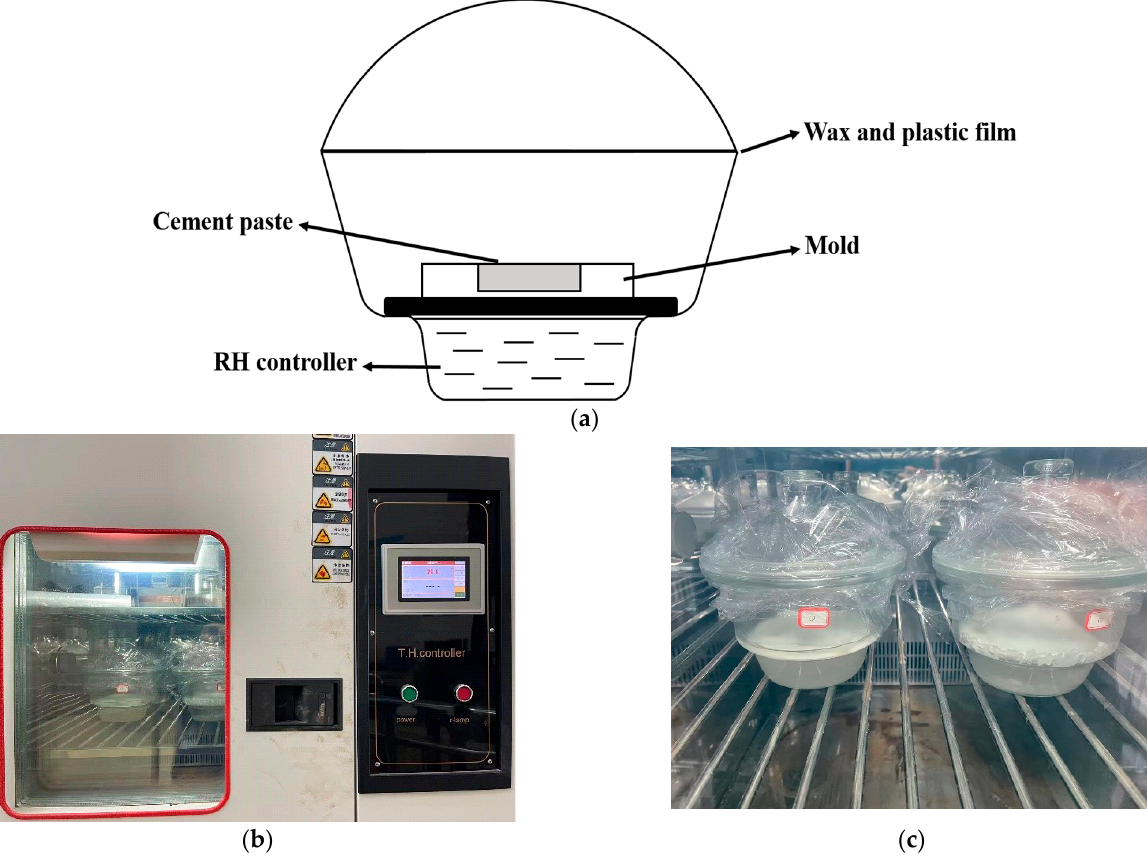
Figure 1. Curing of the samples under different RH conditions. ( a ) Schematic diagram of the drying dishes. ( b ) Temperature and humidity controller. ( c ) The drying dishes containing the cement samples and a saturated salt solution.